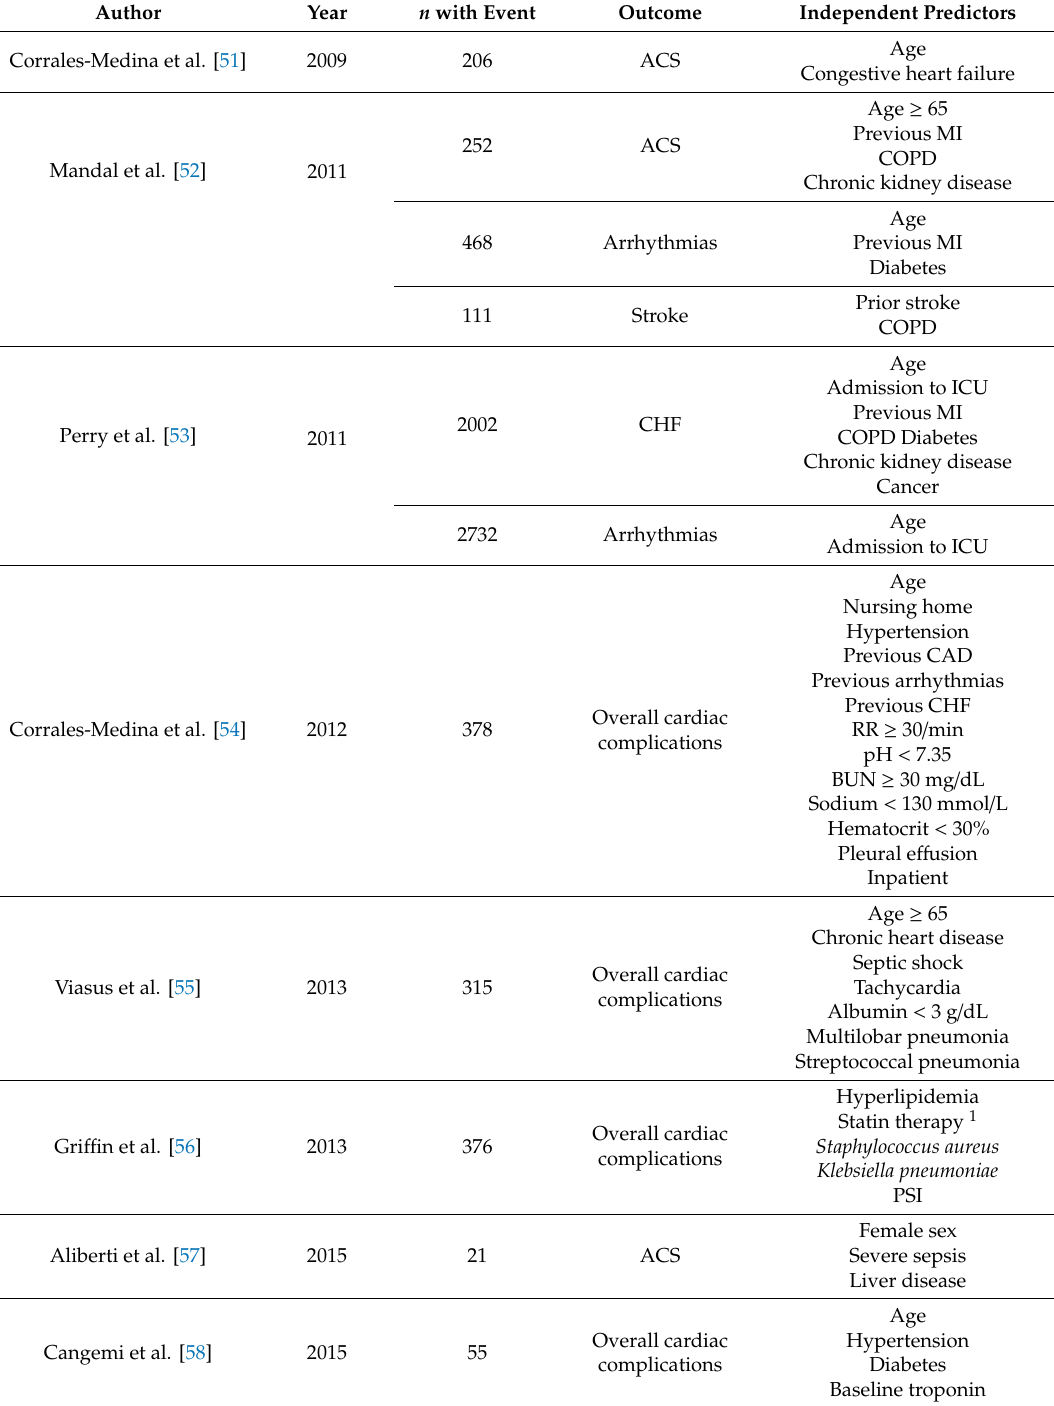
Table 2. Included studies presenting independent predictors of cardiovascular (CV) events after community-acquired pneumonia